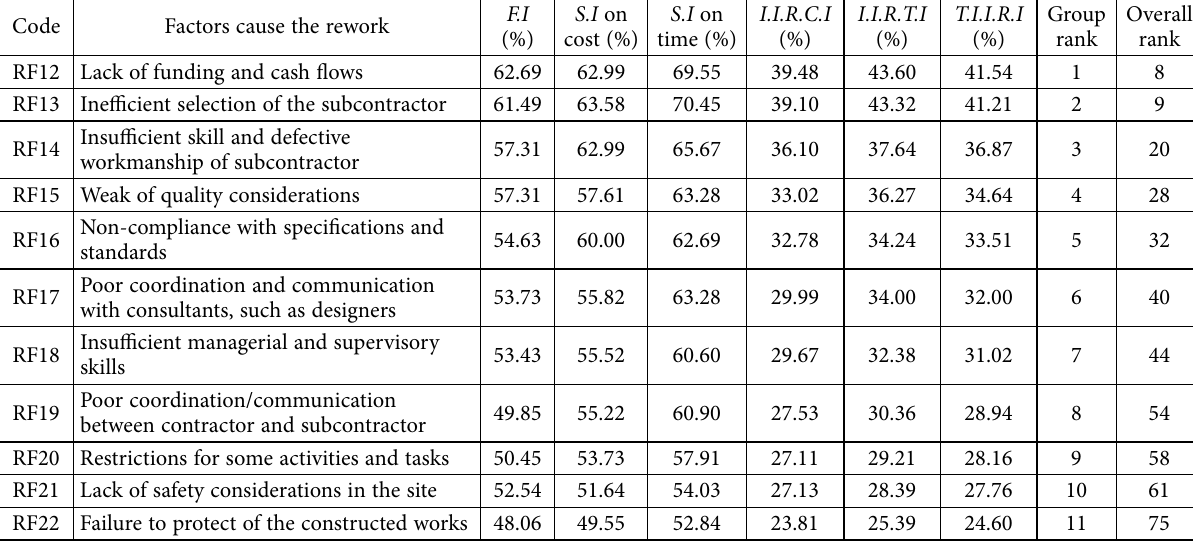
Table 5. Ranking the rework factors related to the contractor and subcontractor